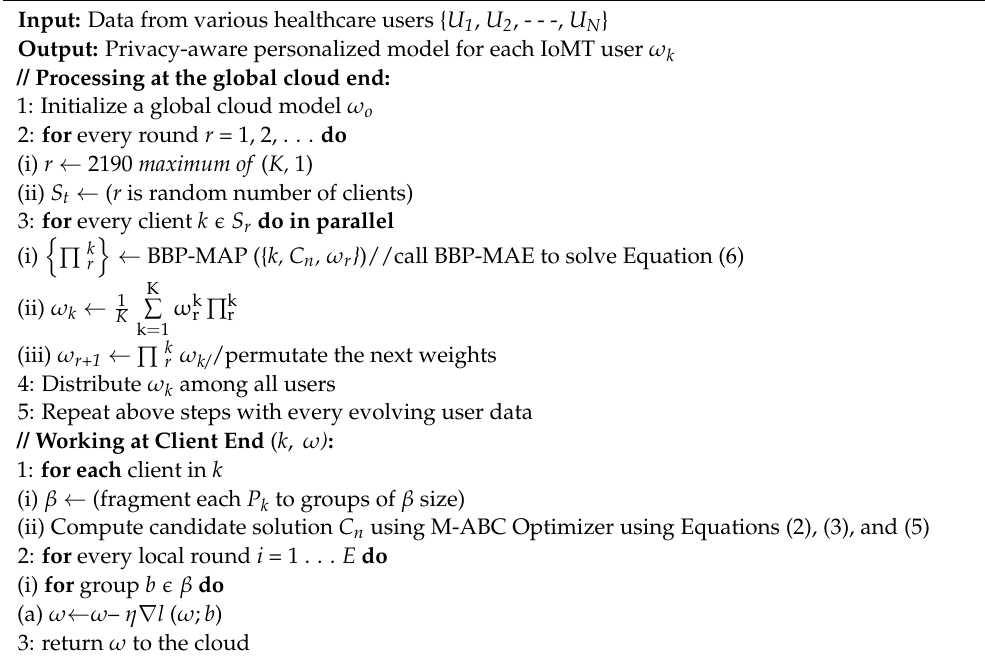
Algorithm 2: Learning method of proposed framework for healthcare. The K number of users is listed as k , local minibatch size is shown by β , learning rate is represented by η , and local epochs are represented using E